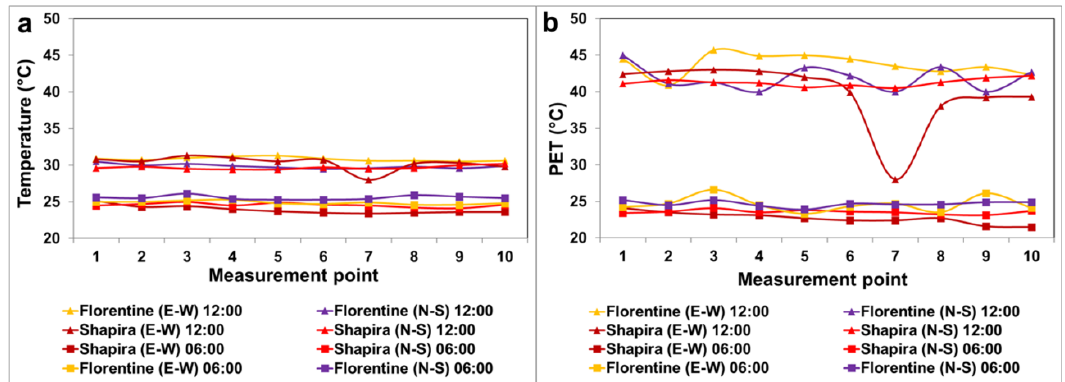
Figure 5. A comparison of ( a ) air temperature and ( b ) physiological equivalent temperature (PET) values along four street cross-sections in the Shapira and Florentine neighborhoods (Each line represents the variability of the air temperature and PET at a selected hour according to the measurement points) at 20 June 12:00 and at 21 June 06:00.